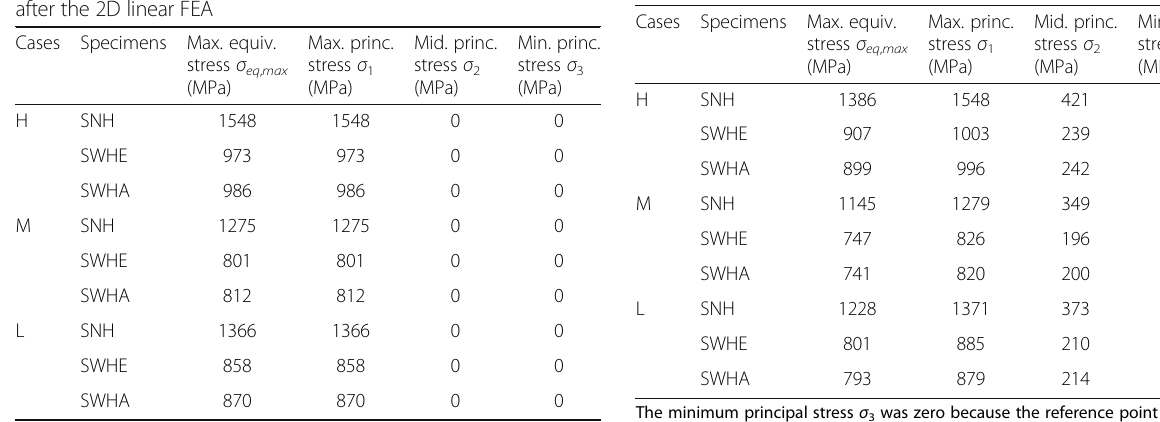
parameters of Table 4, are summarised together with the p(cid:3) (cid:4) ffiffiffiffiffiffiffiffiffiffiffiffiffiffiffiffiffiffi E ε = R values of the factor in Table 9 (for the cor- ertr e tical bone considered as semi-ductile material) and in Table 10 (for the cortical bone considered as ductile material). The relevant factor n pl , the specimen static strength σ SK and the critical opening angle α crit